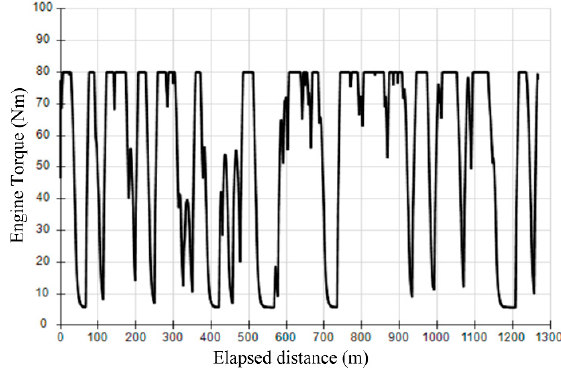
Figure 2. Instantaneous motor’s torque along the track.